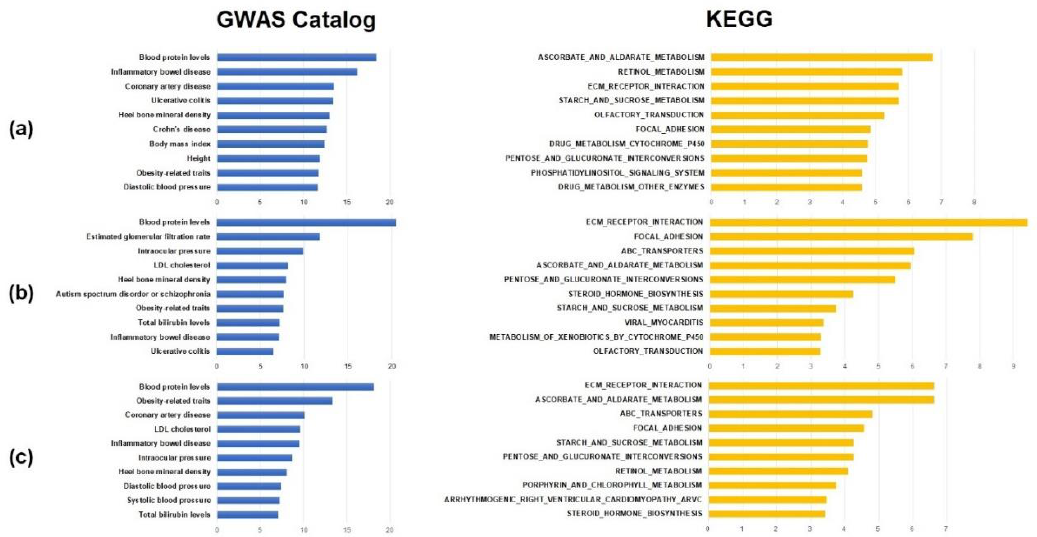
bers indicate common gene sets occurring in results of different phenotypes. ( a ) GWAS catalog gene set, ( b ) KEGG pathway gene set. HTN, hypertension; SBP, systolic blood pressure; DBP, diastolic blood pressure; GWAS, genome-wide association study; KEGG, Kyoto Encyclopedia of Genes and Genomes.